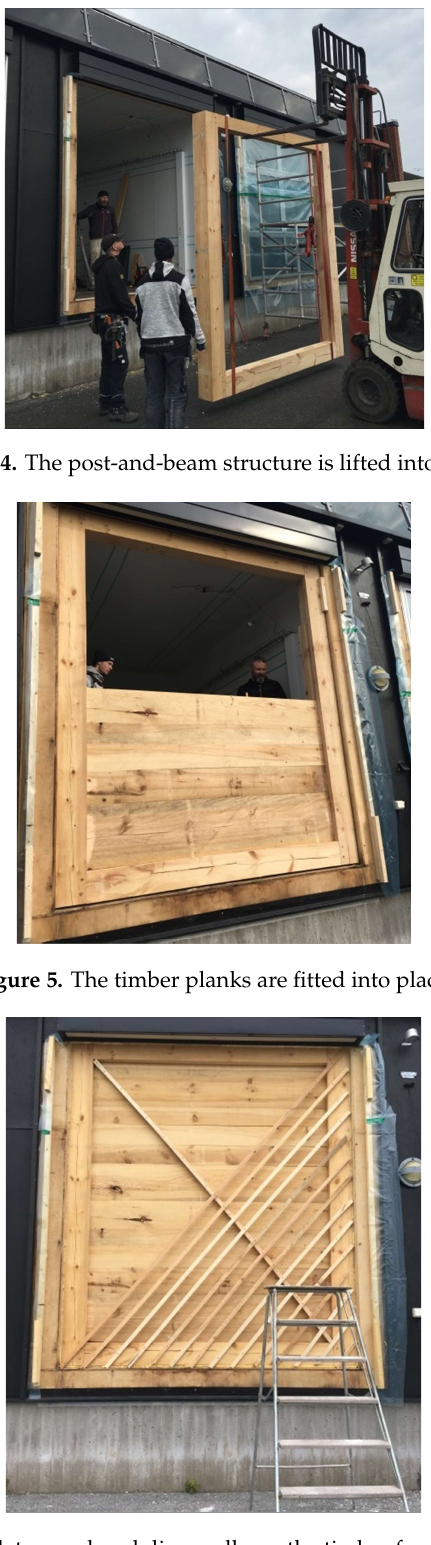
Figure 7. Applying the hemp-lime onto the wall surface. Figure 8. Applying a lime render to one section of the hemp-lime façade.